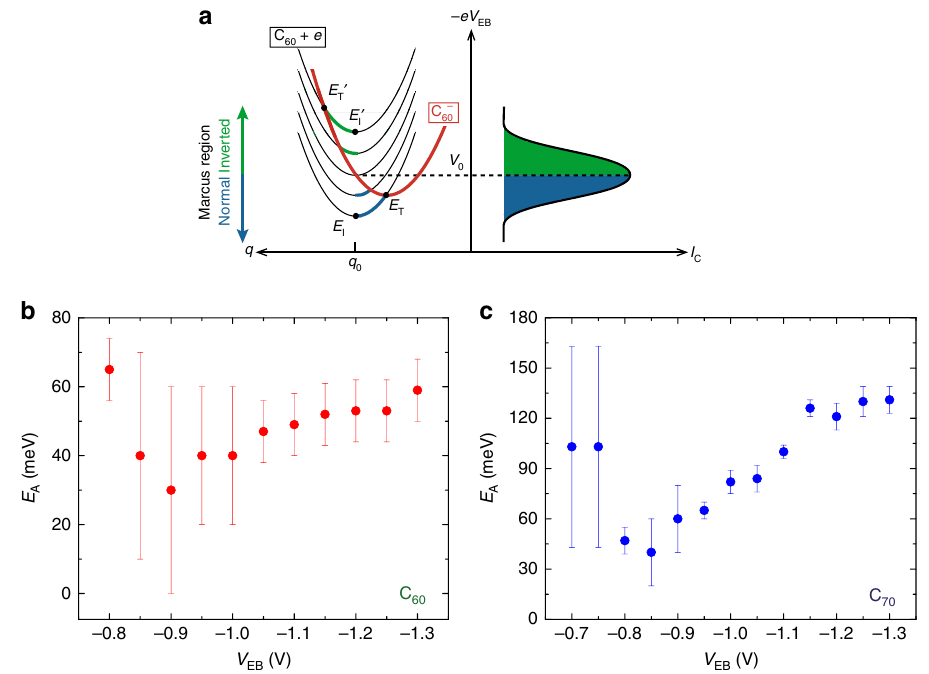
Fig. 3 Marcus Inverted Regime and activation energy. a Illustration of the charge transport in both the Marcus Normal and Inverted Regions. The electronic energy of a neutral C 60 (to whom the hot electrons have not yet reached) plus the hot-electron energy are shown on the left as black parabolas, which are vertically offset by different emitter-base voltages (which correspond to the variation in hot-electron energy). The parabolic shape indicates the dependence of the energy on the deformation along a molecular conformation coordinate, q . The analogous dependence for the negatively charged C (cid:3) (in its fi nal con fi guration, having received an electron) is shown in red. The crossing points between the parabolas de fi ne the transition energy for the charge transport, which is controlled by the emitter-base voltage. As an example, two cases are indicated with transition states E T and E T ’ , which are activated from initial states E I and E I ’ , respectively. The activation energy is de fi ned in general as the difference between the transition and the initial energies such that E A = | E T − E I |. At low voltages, exempli fi ed in the transition from E I to E T , the barrier (left) decreases and the output current (blue shaded area on the right) increases as the voltage increases in which is commonly denoted as Marcus Normal Region. The barrier is minimised at V 0 leading to the maximum injection current (right). For an even larger driving force, exempli fi ed now in the transition from E I ’ to E T ’ , the current decreases (green shaded area on the right) due to the increased barrier. This is commonly called the Marcus Inverted Region. b Dependence of the activation energy E A of C 60 on V V = − 0.9 V position. Error bars are from fi t uncertainties (s.e.m.). c Dependence of the activation energy E EB , which shows a minimum at the EB on V EB , which shows a minimum at the V EB = − 0.85V position. Error bars are fi t uncertainties